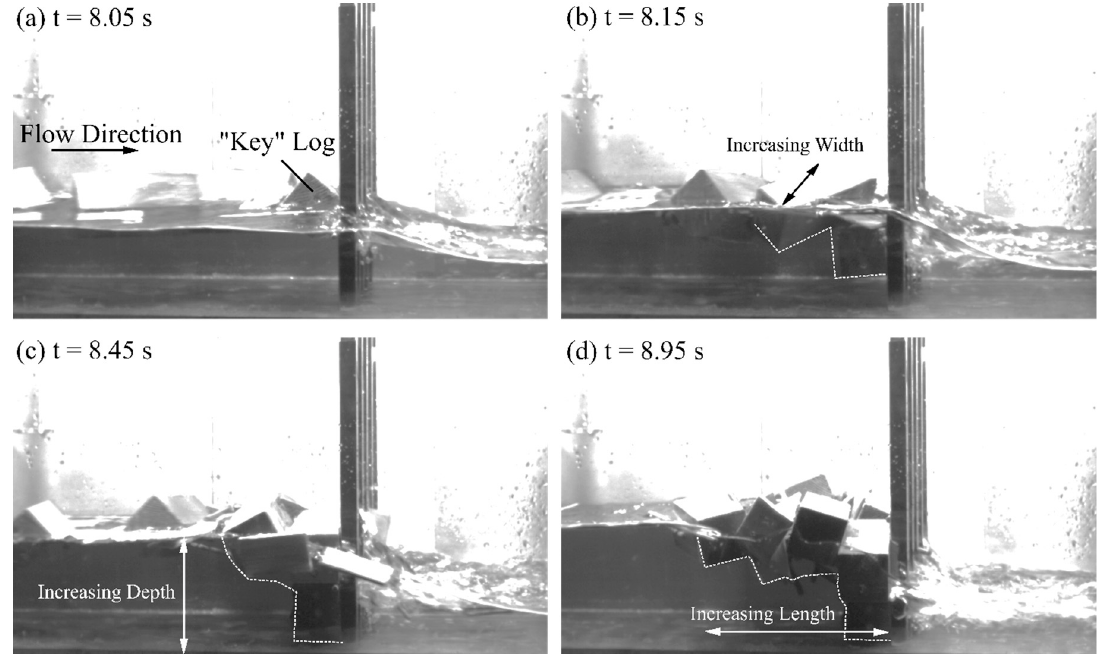
Figure 9. Qualitative examination of debris dam formation: ( a ) capture of the "key" log; ( b ) increasing width of the dam; ( c ) increasing depth of the dam; and ( d ) increasing length of the dam. White dashed line shows the outline of the dam under the water surface.